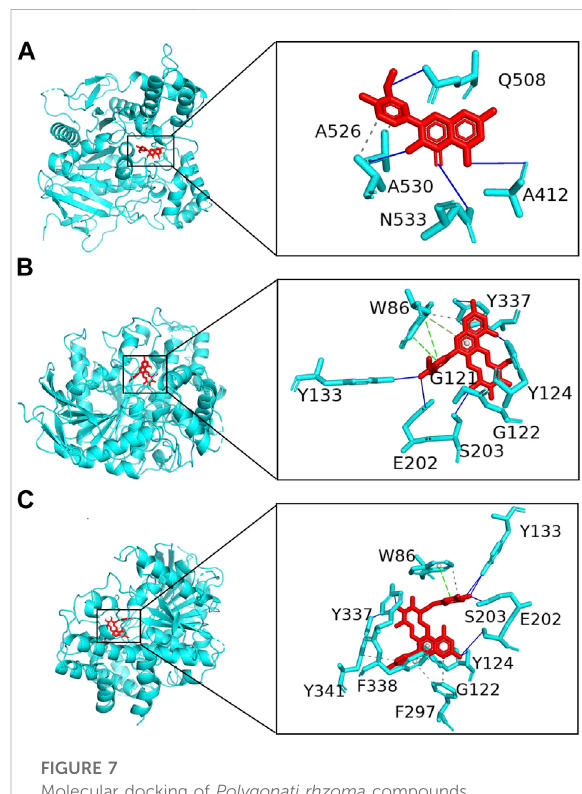
FIGURE 7 Molecular docking of Polygonati rhzoma compounds isorhamnetin (A) ,rutin (B) ,andsyringetin-3-O-glucoside (C) witha target of